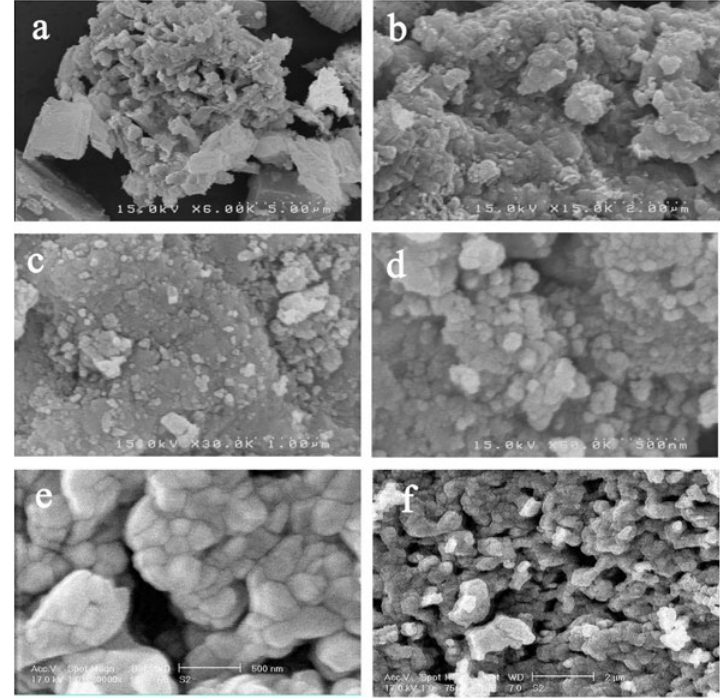
Fig. 8. Surface morphology (SEM image) of as-prepared [Cu(BDC)(bipy)](BDCH